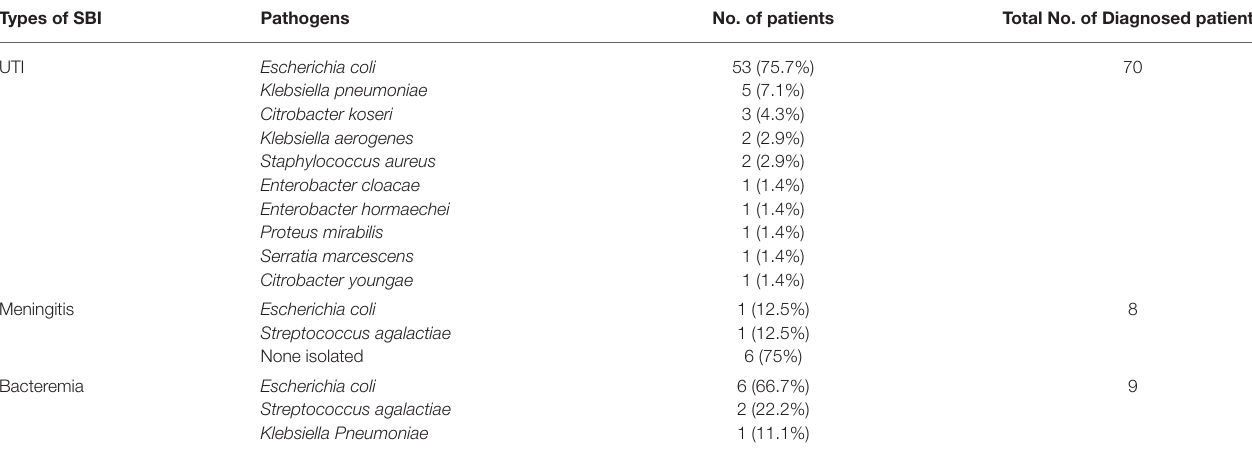
TABLE 3 | Microbiology results of infants with SBIs in our study cohort.